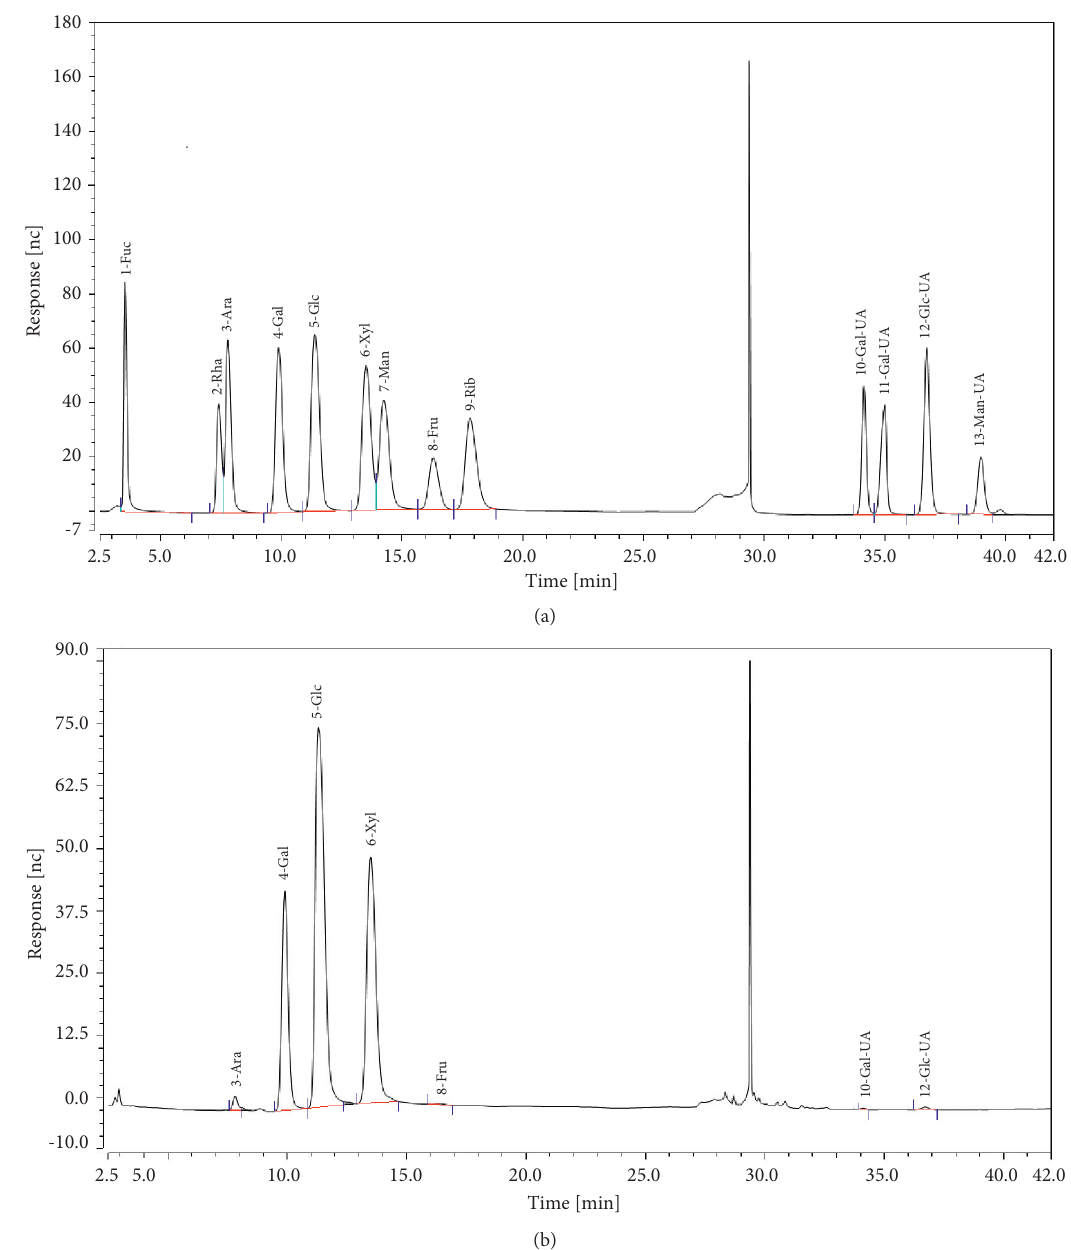
Figure 2: High-performance anion-exchange chromatography (HPAEC) of TSP: (a) HPAEG chromatography of standard mixture with glucose, xylose, galactose, arabinose, fructose, glucuronic acid, glucuronic acid, fucose, rhamnose, mannose, ribose, mannuronic acid, and guluronic acid and (b) HPAEG chromatography of